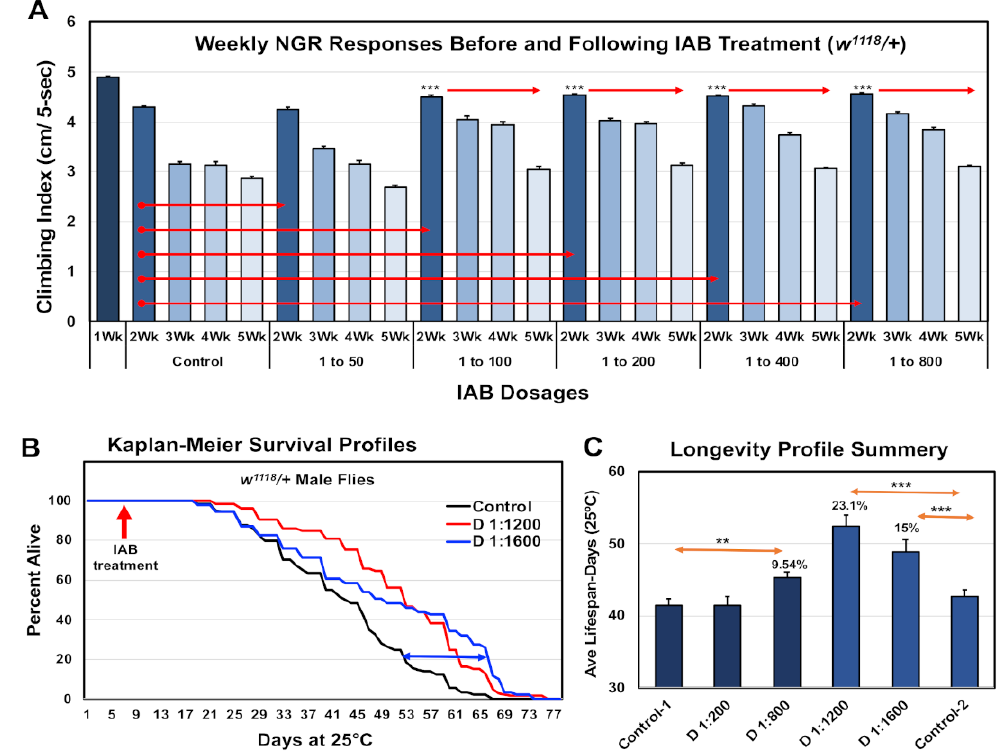
Figure 1. Therapeutic impact of inactive bacteriologic (IAB) dosages on Drosophila neural function and longevity. ( A ) Nega- tive geotaxis responses of controls (0) and male fly cohorts exposed to IAB at 1:50, 1:100, 1:200, 1:400, or 1:800 dilutions. Starting at one week of age, climbing indexes were determined weekly (Wk). ( B ) Longevity profiles of fly cohorts exposed to media containing 0, 1:1200, or 1:1600 IAB dilutions. ( C ) Average and SEM summary profiles of two independent longevity studies (** p -values < 0.01, *** p -values < 0.001). See Supplementary Table S1A,B for fly numbers ( n ) and additional